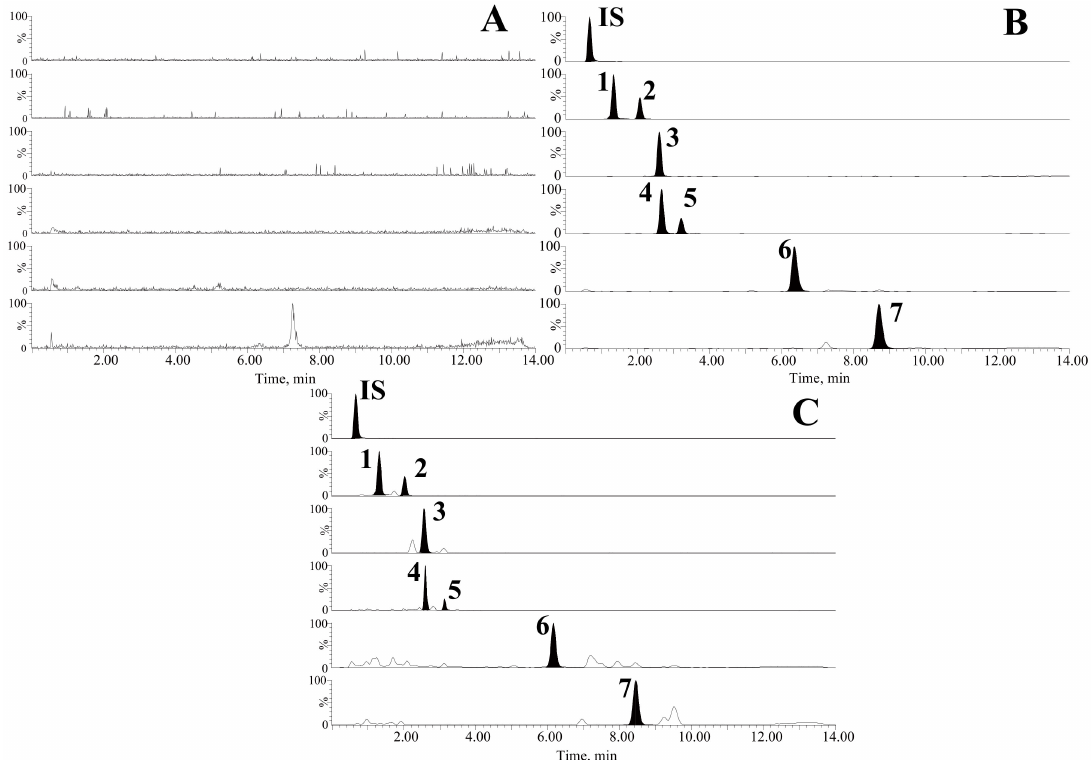
Figure 3. Typical UHPLC-MS/MS chromatograms of ( A ) blank plasma, ( B ) blank plasma spiked with the analytes and IS, and ( C ) plasma sample from a normal rat at 6 h after oral administration of TAE, which were detected with multiple reaction monitoring mode.; ceanothic acid (1), epiceanothic acid (2), pomonic acid (3), alphitolic acid (4), maslinic acid (5), betulinic acid (6), betulonic acid